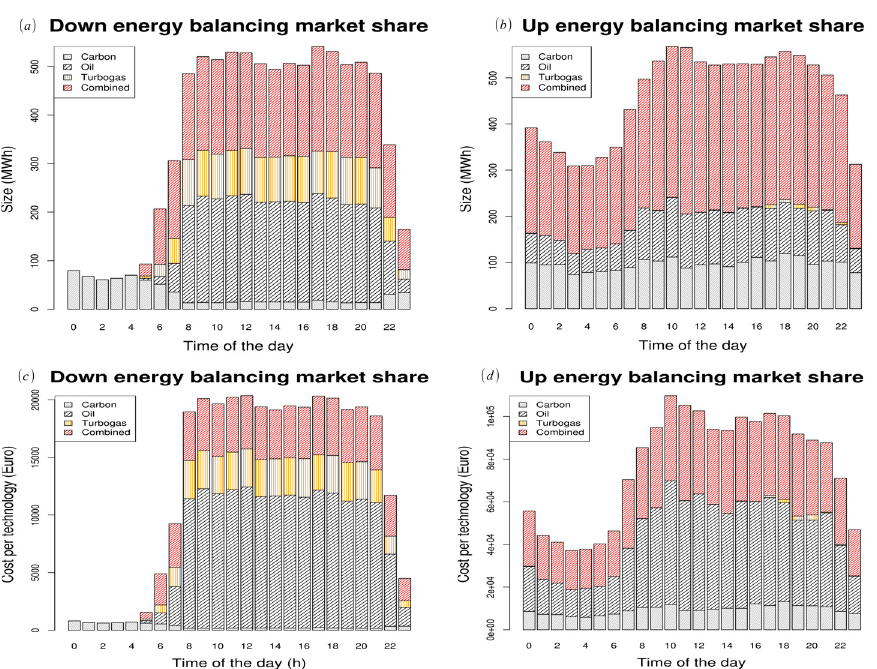
in the balancing market. notice that our model is able to detail the contribution of each conventional power plant technology. As expected, due to low ramping (i.e. slowness in changing operational conditions), carbon sources have a very low impact on the balancing market even if they have often the lowest